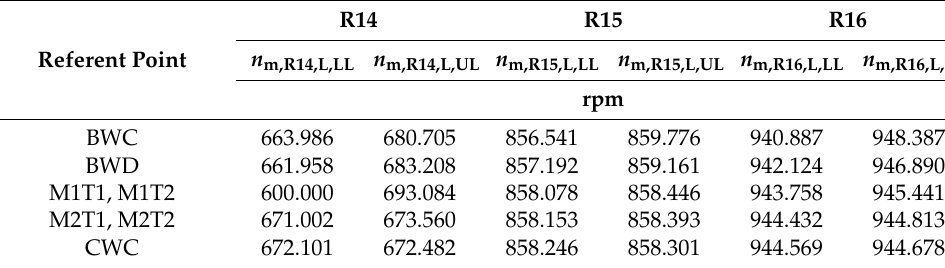
Table 14. Boundaries of the FREM resonant domains according to a L,per –EHO: 5.